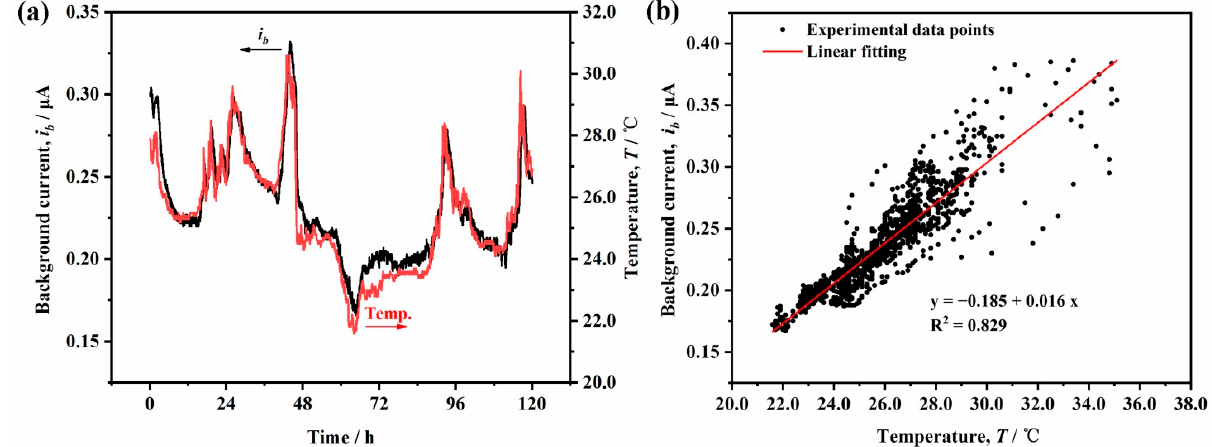
Figure 6. Variations of the background current with environment temperature ( a ), and the relationship between the background current and environment temperature ( b ).